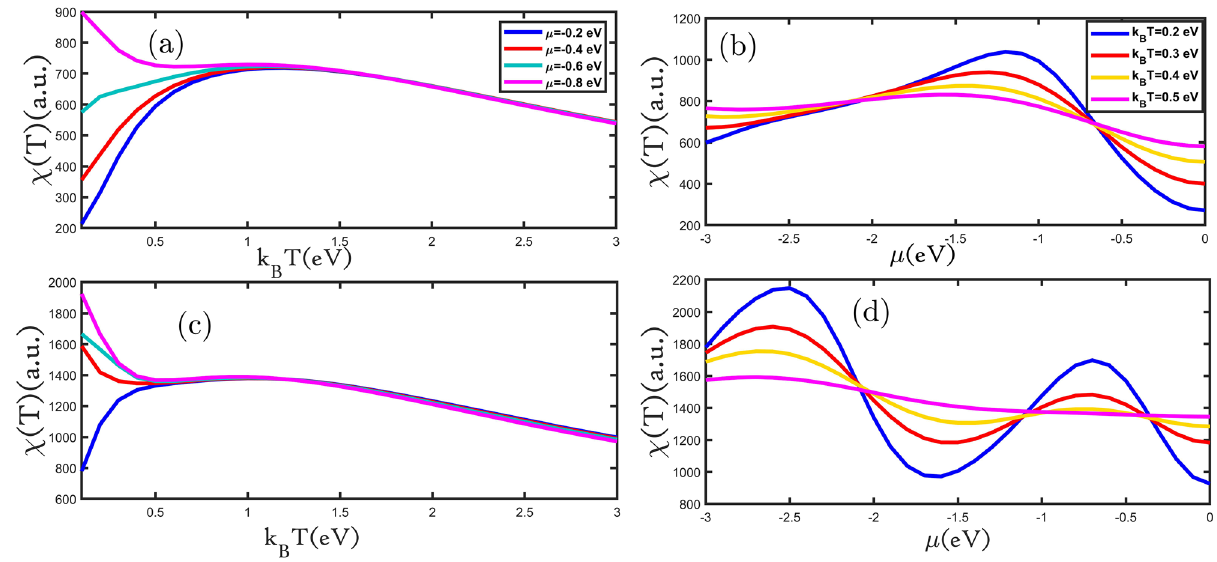
Figure 8. ( a – d ) the magnetic susceptibility as a function of the temperature (hole doping) for planar and buckled silicene monolayers in the presence of different hole doping (temperatures),